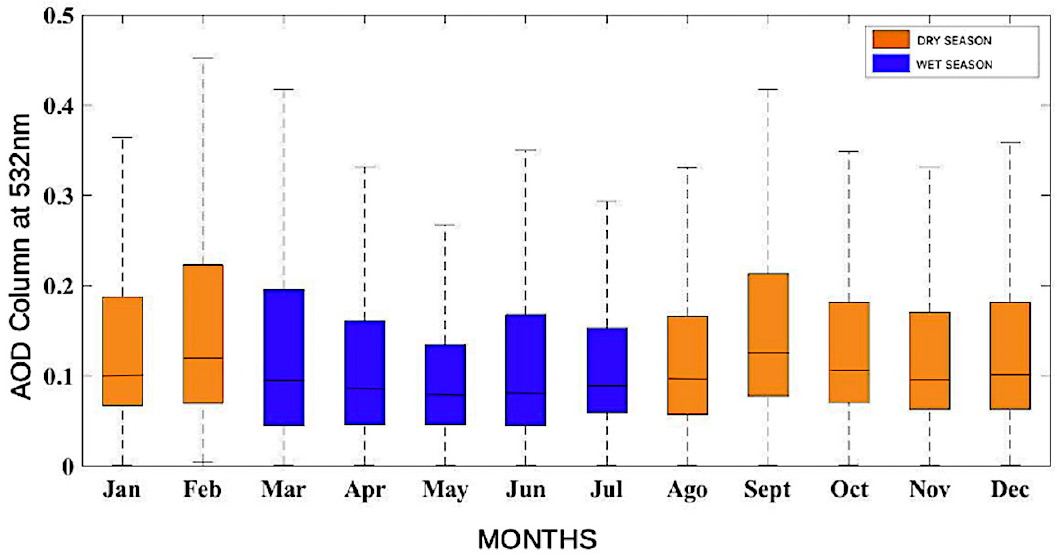
Figure 5. Box plot of the monthly AOD variation from CALIOP / CALIPSO Lidar data at 532 nm in Natal, for the period of 2007 to 2016. The dry season (August to February) is depicted in orange, while the wet season (March to July) is represented in blue.